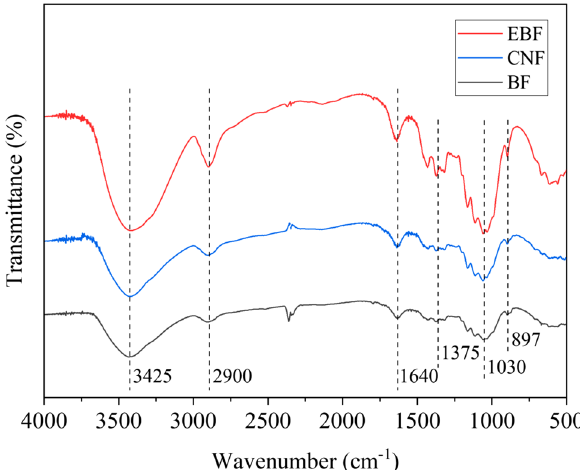
Figure 4. FTIR spectra of BFs, EBFs, and CNFs.